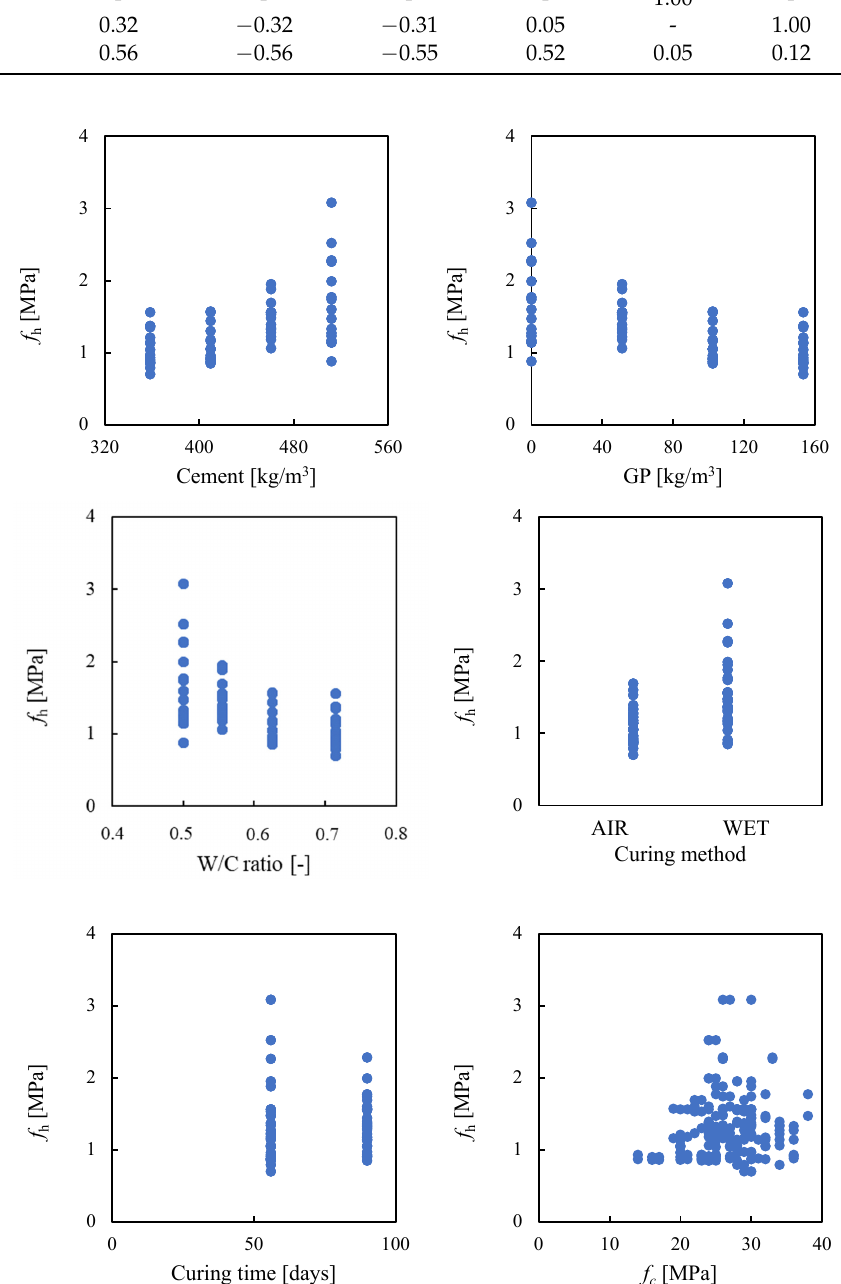
Figure 6. The relation between input variables and tensile strength. Table 3. Correlation matrix of the input and output variables.